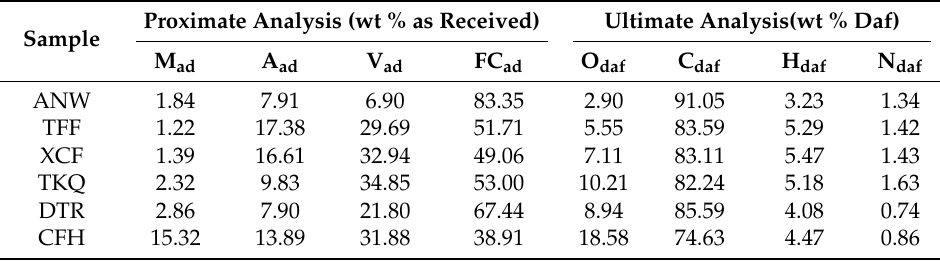
Table 5. The proximate and ultimate analysis of the six coal samples.